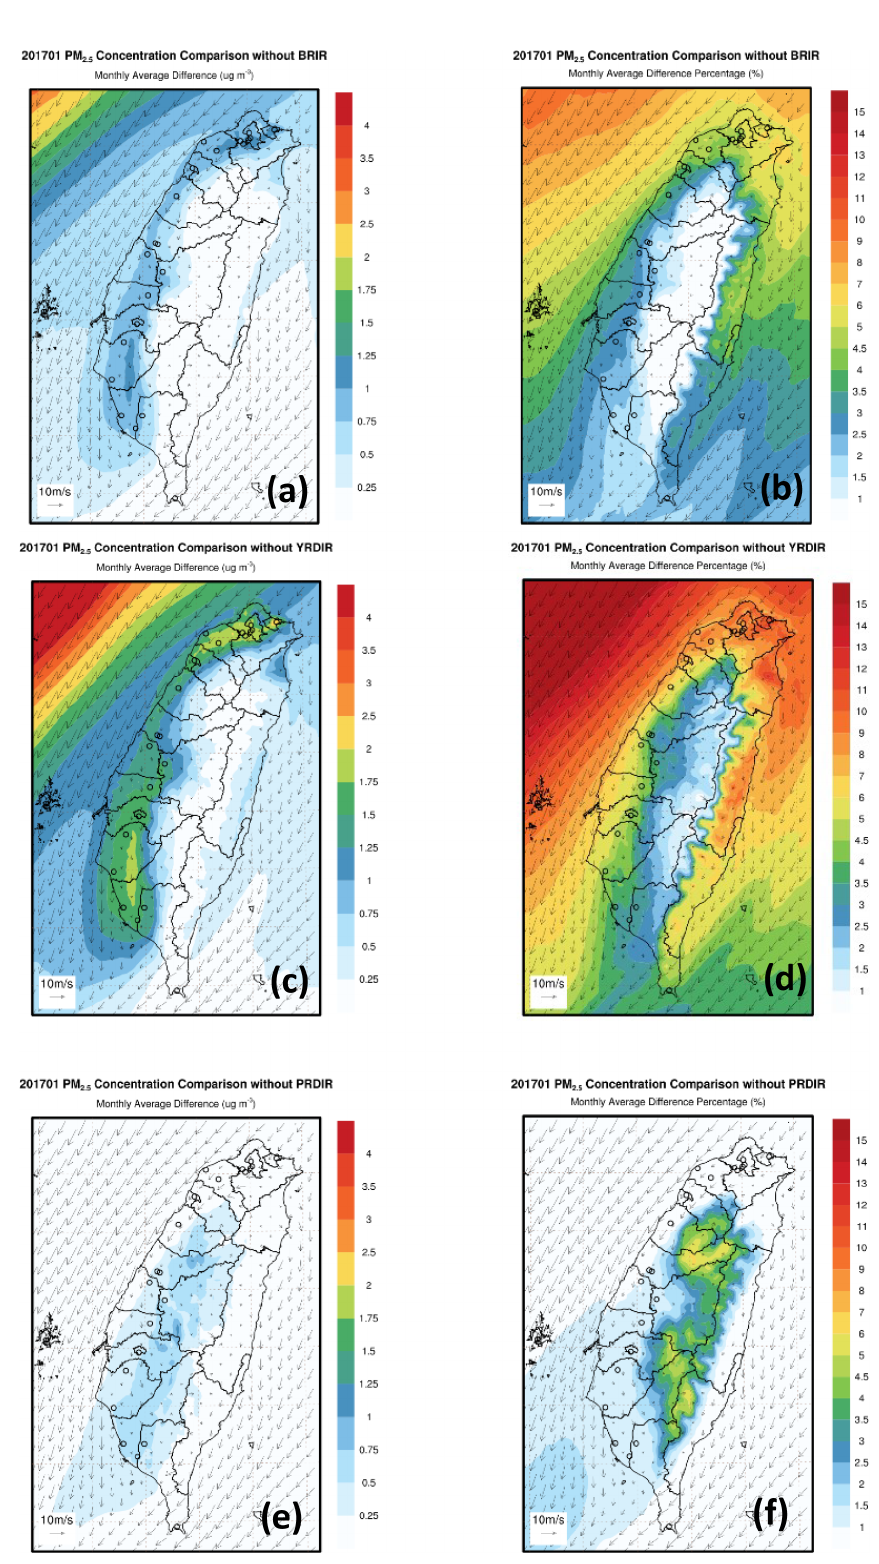
Figure 2. The monthly average wind field and impact of PM 2 . 5 from the three industrial regions on Taiwan in January 2017. BRIR (the difference between base and zero-out scenarios) – concentration (a) and percentage (b) . YRDIR – concentration (c) and percentage (d) . PRDIR –concentration (e) and percentage (f)